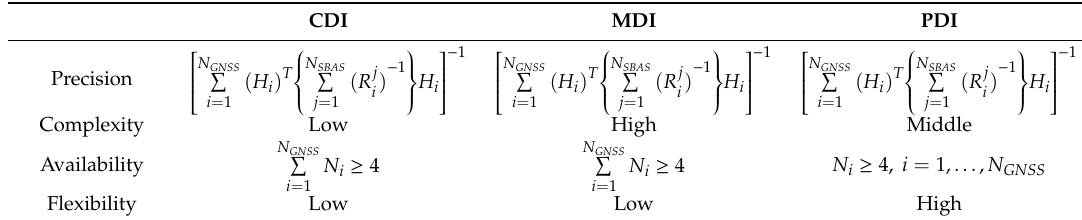
Table 3. Comparison of CDI, MDI, and PDI.